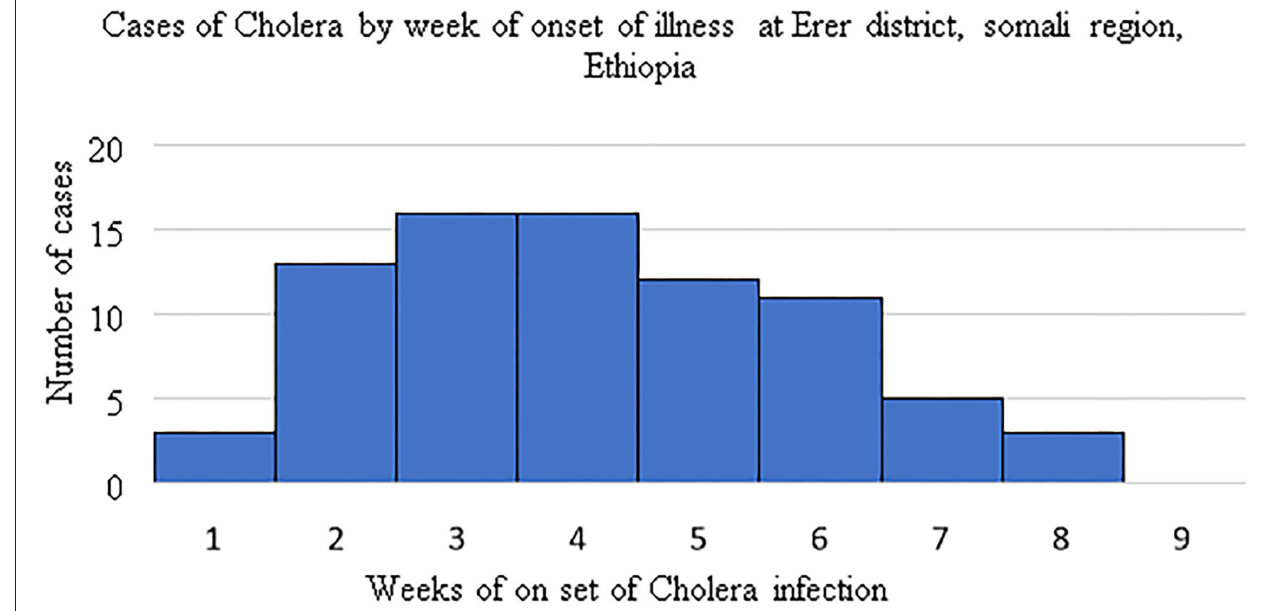
FIGURE 1 | Cholera cases by week of onset of illness, Erer district, Somali region, Ethiopia: 4th September to 1st November 2019.